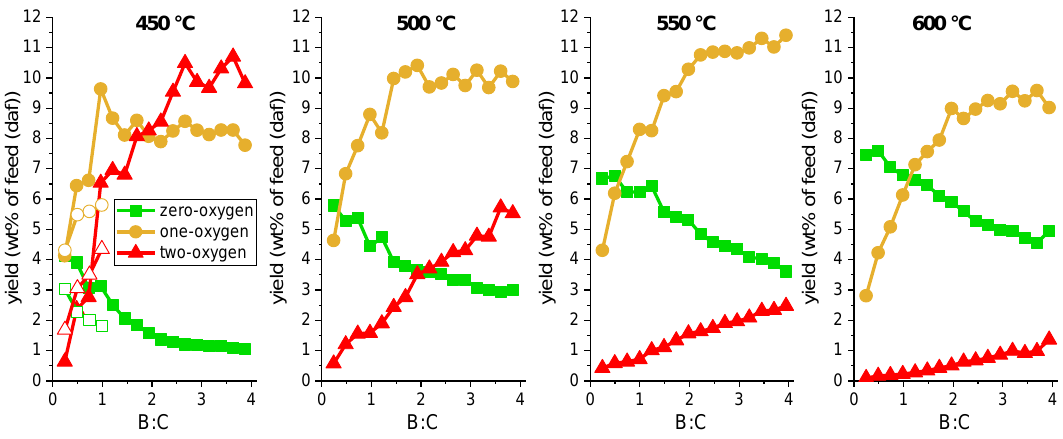
Figure 8. Yields (wt% of fed biomass (daf)) of hydrocarbons containing zero, one, and two or more oxygen atoms for upgrading over P/HZSM-5/γ-Al 2 O 3 at different constant catalyst temperatures. The momentary yields obtained at each biomass injection as a function of increasing cumulative B:C ratio are shown. Open symbols in the left graph were obtained for repeated runs with a new catalyst to B:C ~1. Legend applies to all graphs.